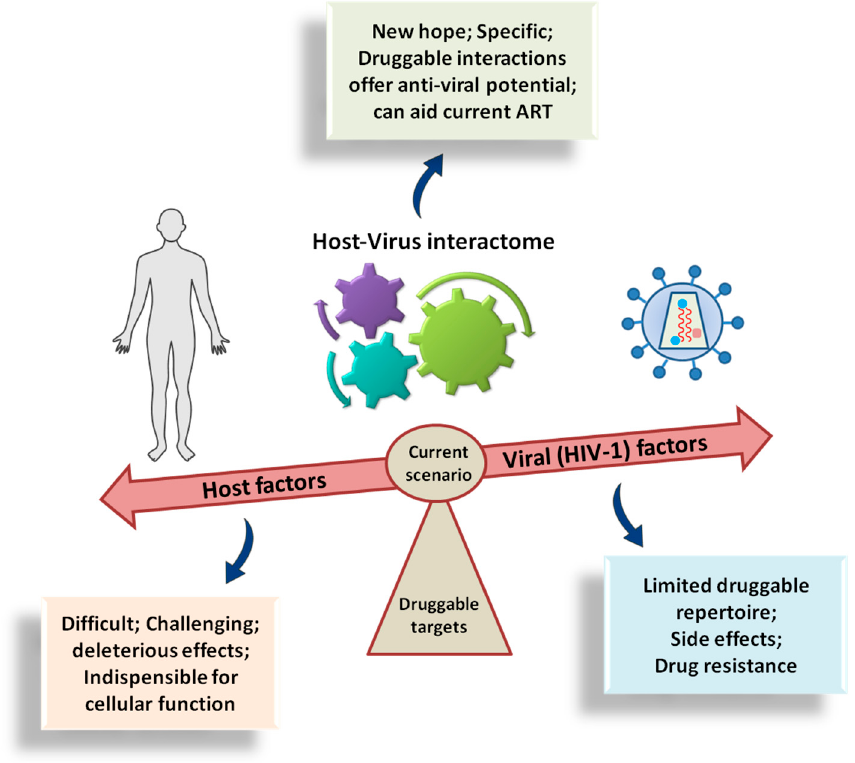
Figure 8. Cartoon depiction of the current scenario showing the drug targets for anti-viral (anti-HIV)